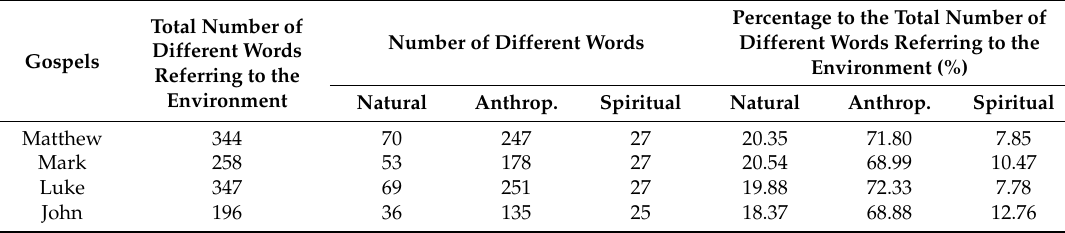
Table 3. Unique words referencing the environment, according to the General Environmental Categories.